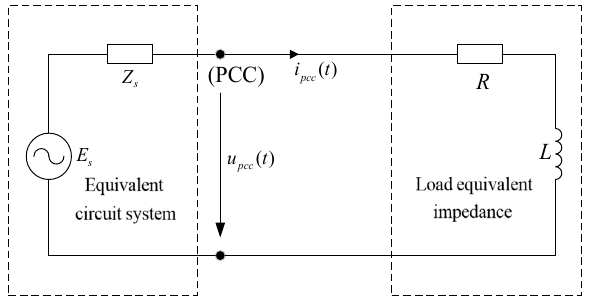
( c ) Figure 7. Phase A harmonic voltage simulation: ( a ) different transformer capacity used; ( b ) differ- ent line lengths; ( c ) the locomotive is in different positions on the line. Therefore, the influence of key factors can be summarized as: (1) The size of high-order harmonics in the low-voltage three-phase system will be af- fected by the capacity of the transformer used. When the capacity is small, the im- pact is greater, but when the capacity is large, there is no significant impact;